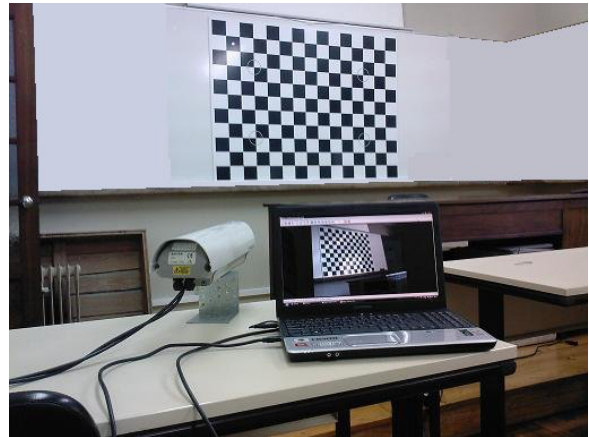
Figure 4. Image acquisition for camera interior orientation.